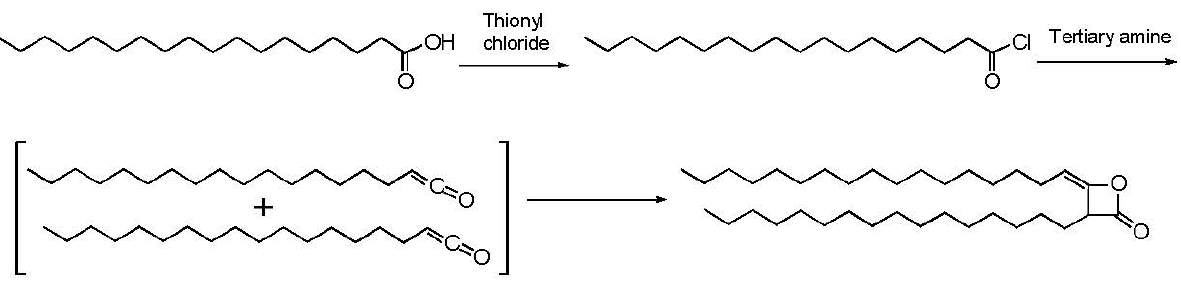
Figure 6. Formation of alkyl ketene dimers.